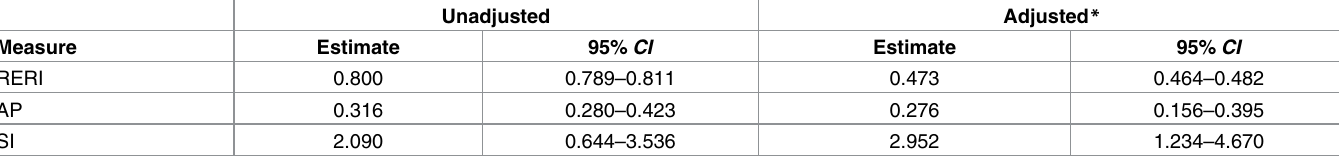
Table 5. Index of additive biological interactive effect of CMI quintile and prediabetes on